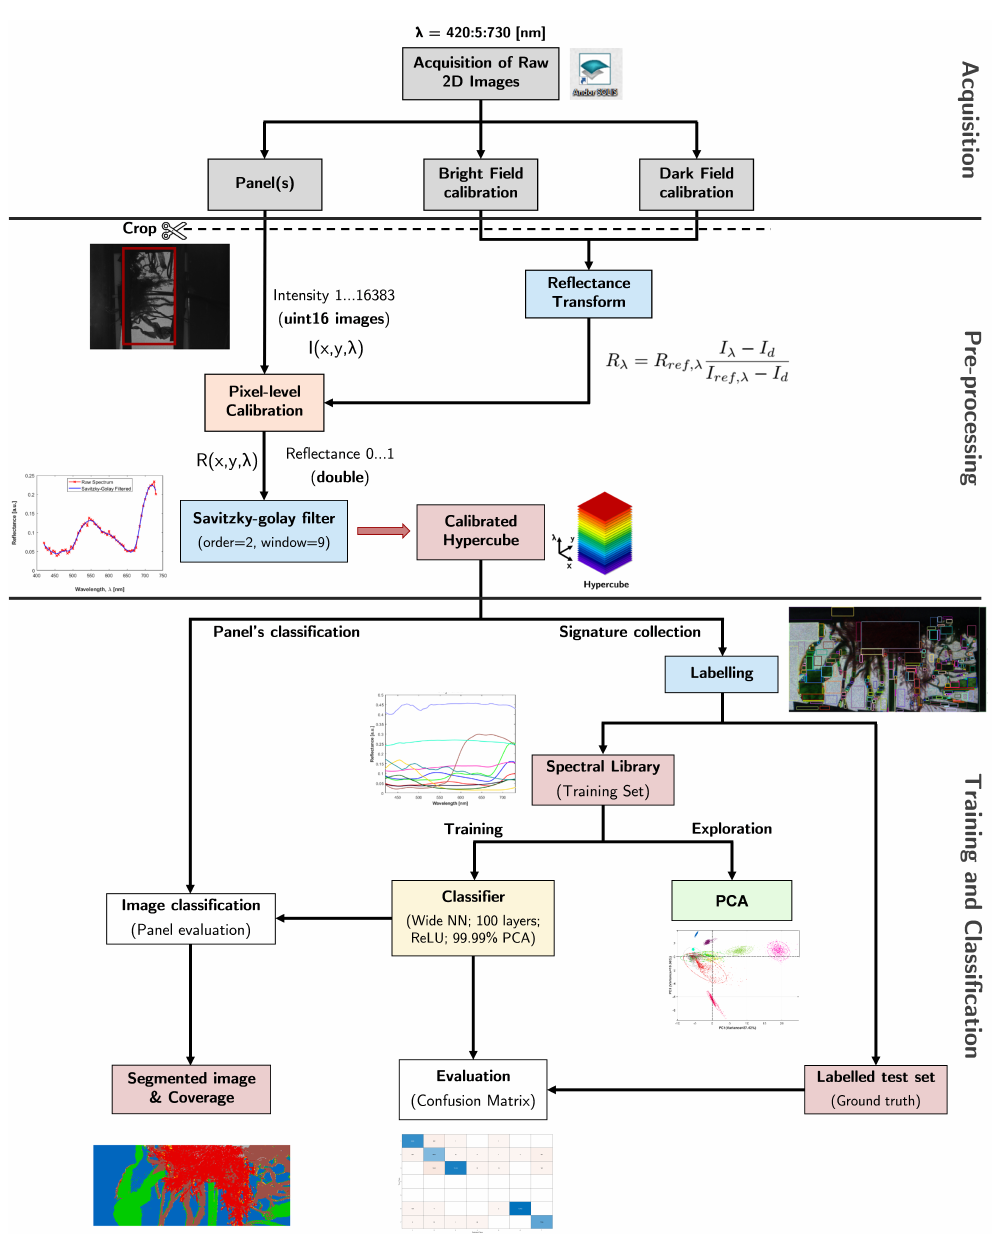
Figure 5. Workflow for pre-processing, training of the model, and classification of fouled